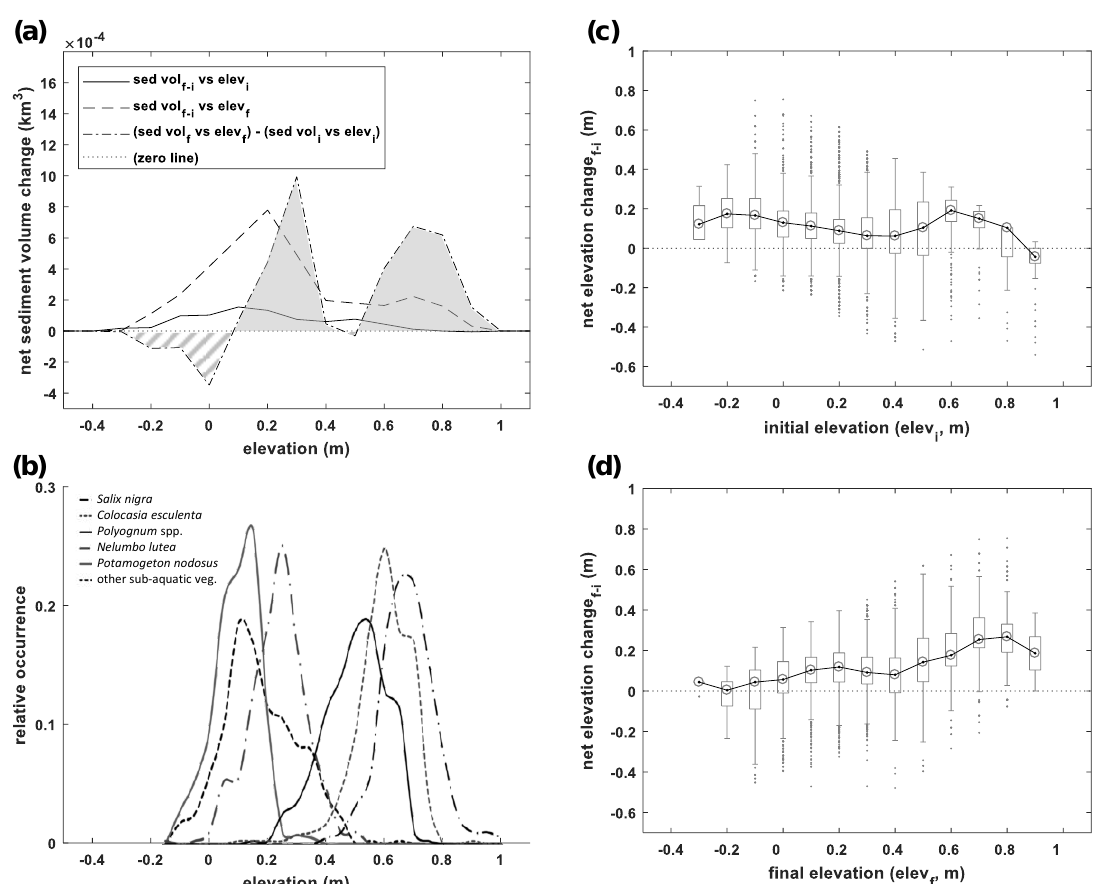
Figure 10. ( a ) Net change in WLD subaerial sediment volume over two decades, from the initial (1993–1995) to final (2011–2013) HIME timeframes of study, as experienced by discrete marsh top elevation zones (X-axis calculated as bins of z ± 0.05 m width); the marsh elevation zones (X-axis) were assessed for either the initial (elev i ) or final (elev f ) timeframe. Net sediment accumulation at a given elevation is shaded, net sediment volume loss is hatched. ( b ) Elevation histograms of occurrence of six key vegetation species / groups at WLD, as developed from a 400-point random sample of 30-m pixels on Pintail Island by Carle, Sasser, and Roberts (2015) [32]. Adapted from Carle, Sasser, and Roberts (2015). Reproduced with permission from the Coastal Education and Research Foundation, Inc, Seattle, WA, USA. ( c ) Boxplots of net HIME elevation change, as experienced by WLD pixels beginning within discrete elevation zones ( z i ± 0.05 m) at the initial timeframe. ( d ) Boxplots of net HIME elevation change, as experienced by WLD pixels ending within discrete elevation zones at the final timeframe. Boxplots illustrate median (central points, connected by line), interquartile range (IQR: 25th to 75th percentiles as box bottom and top), 1.5 × IQR whisker lengths, and outliers (dots); boxplots are based on varying numbers of points per elevation zone. All elevations in meters NAVD88.